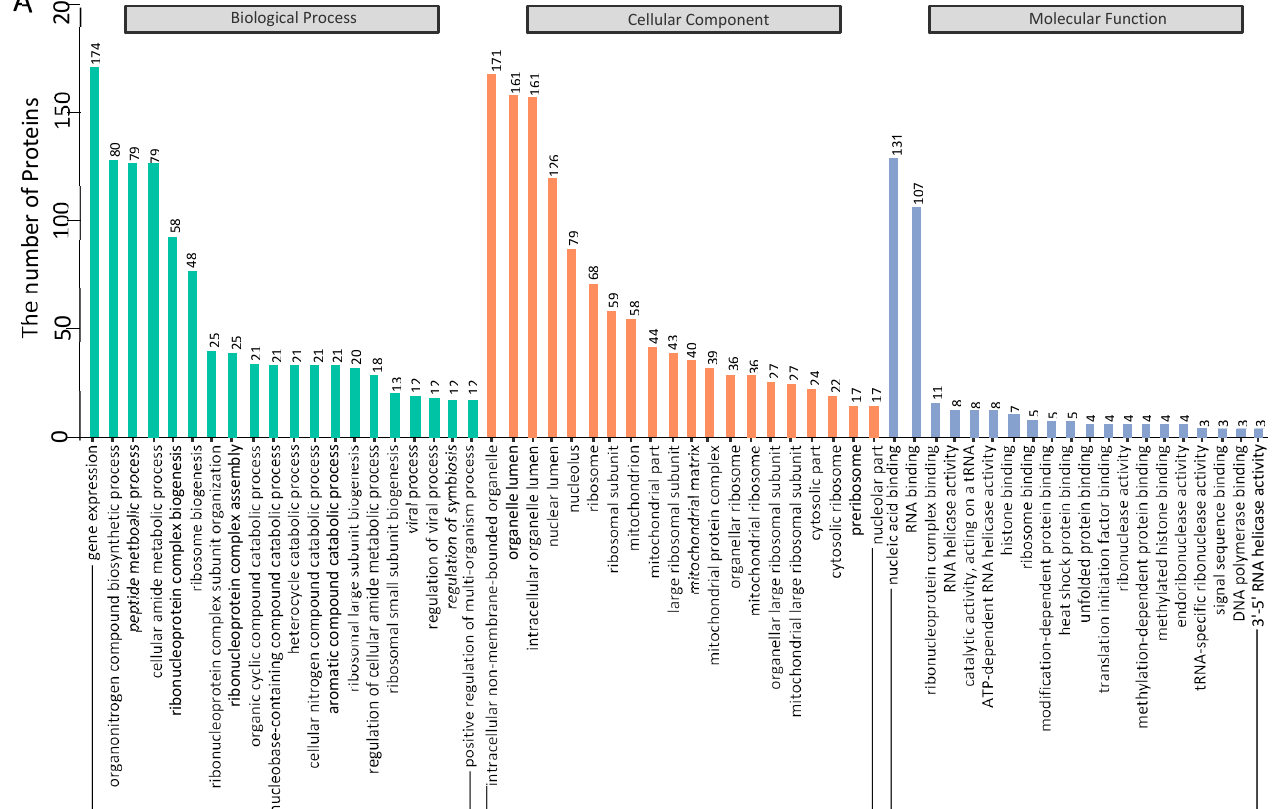
database. Each edge color indicates a different method of protein–protein interaction prediction, as